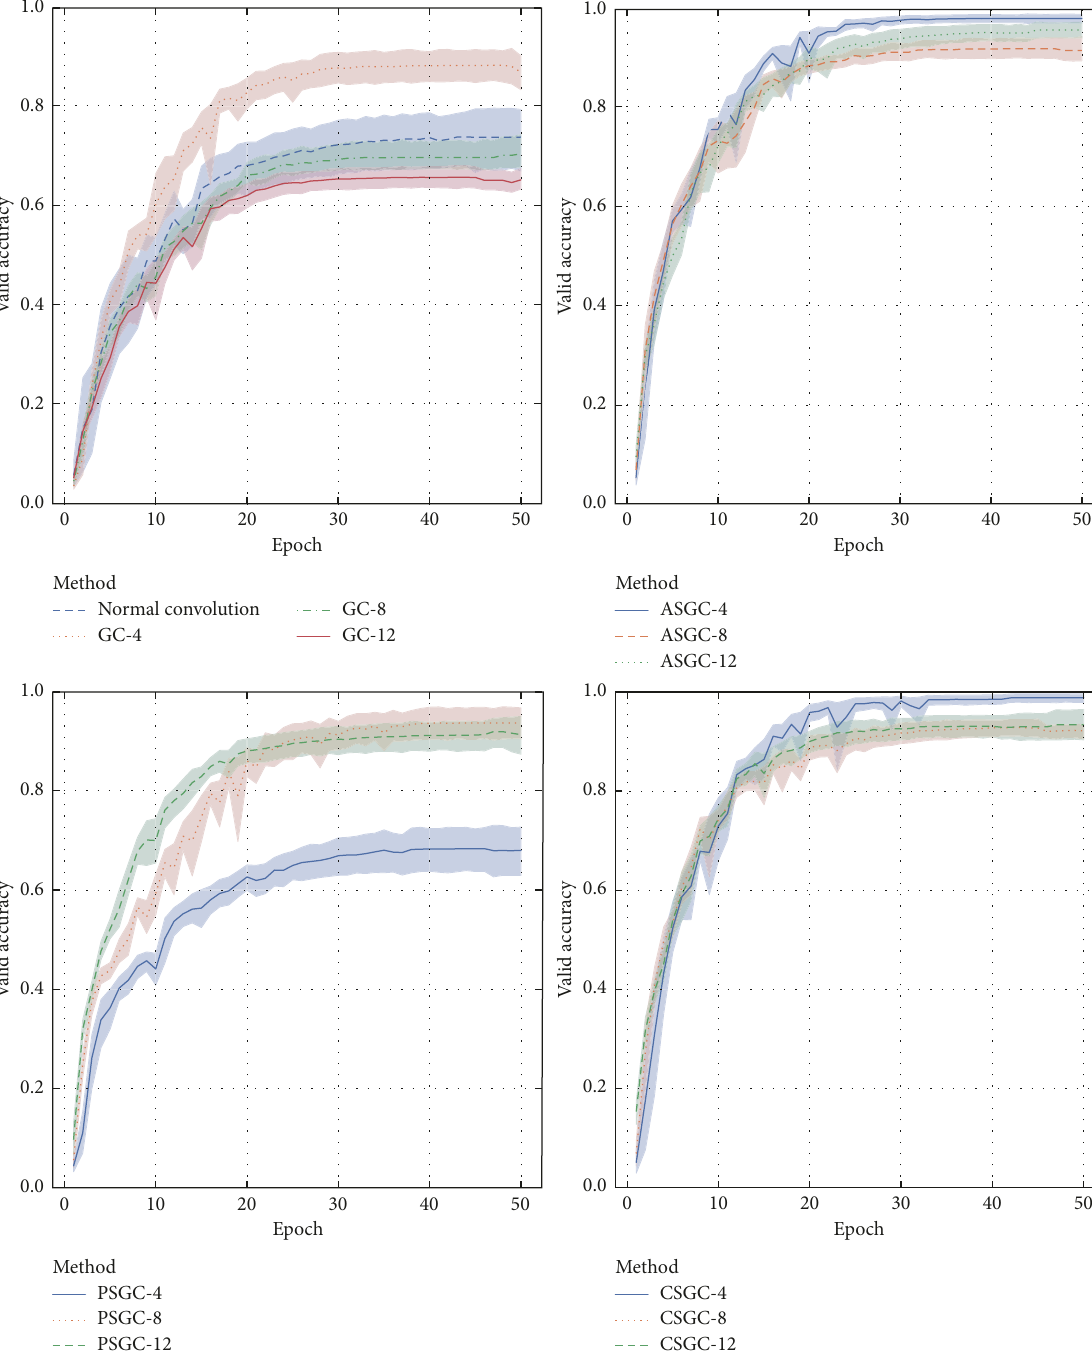
Figure 8: Training curves for comparative methods. Curves are averages over ten trials, and error bands give standard